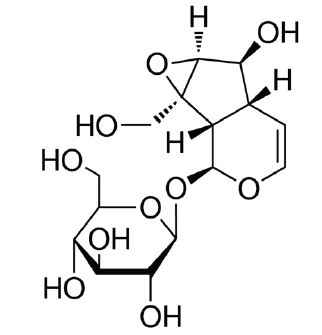
Figure 1. The chemical structure of catalpol.